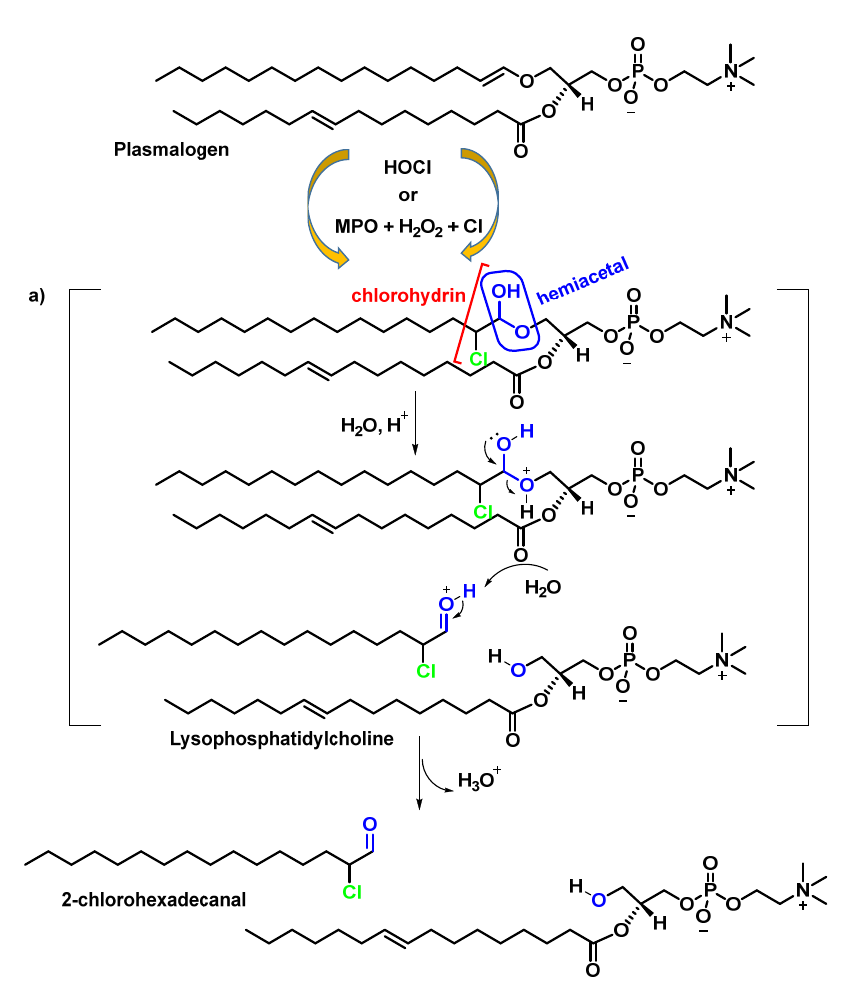
Figure 9. Synthesis of epoxy-cholesterol by intramolecular Williamson reaction via an intramolecu- lar SN 2 reaction.